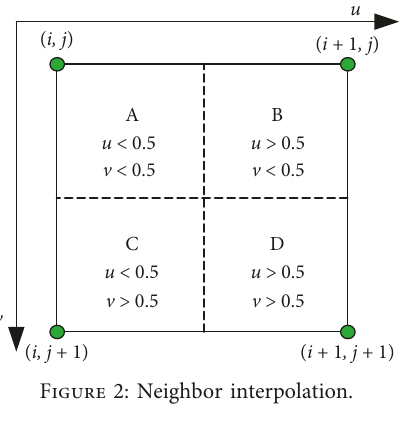
Figure 2: Neighbor interpolation.